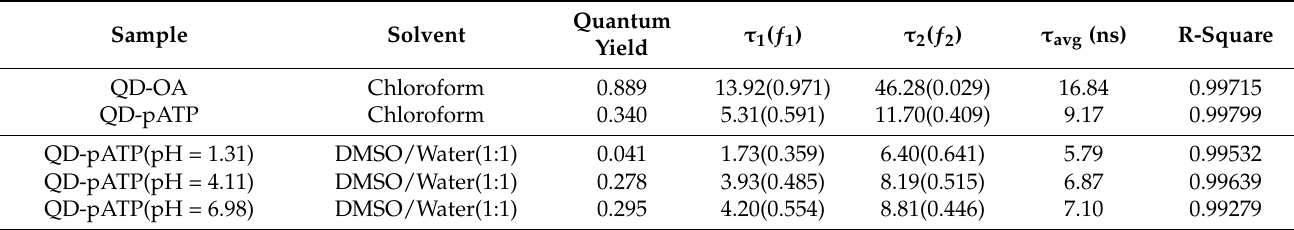
Table 1. The quantum yield and biexponential fit parameters from fluorescence lifetime measurement 1